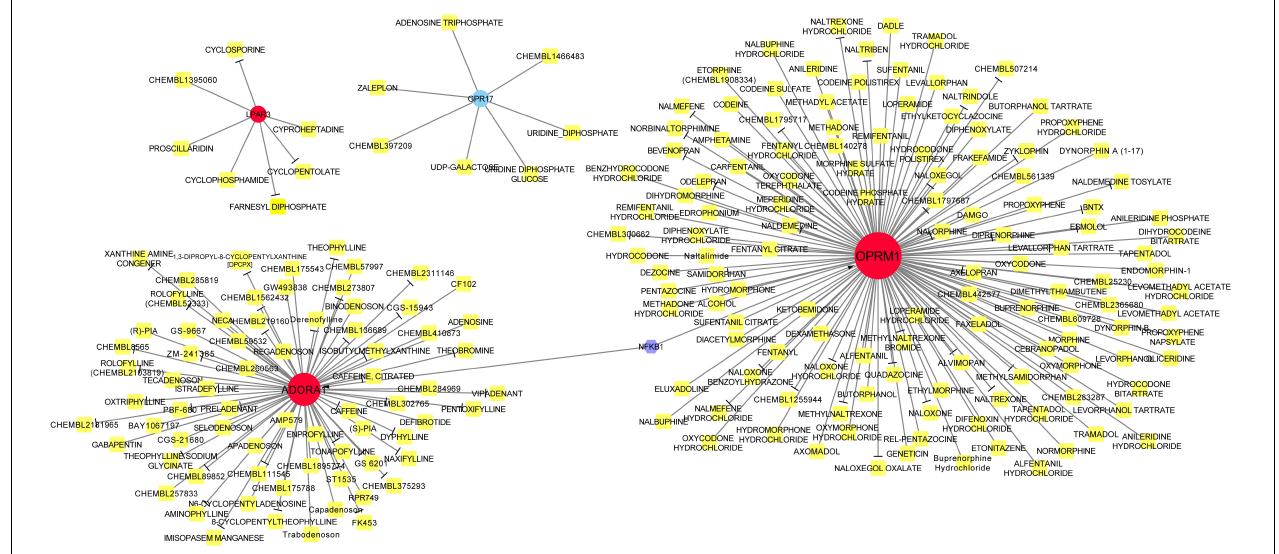
FIGURE 6 | Drug-target-transcription factor (TF) network. Red circles represent upregulated genes, whereas blue circle represents downregulated genes. Yellow squares are drugs and the purple hexagon is the TF. T-arrow indicates the drug acts as an antagonist to this specific molecular target.